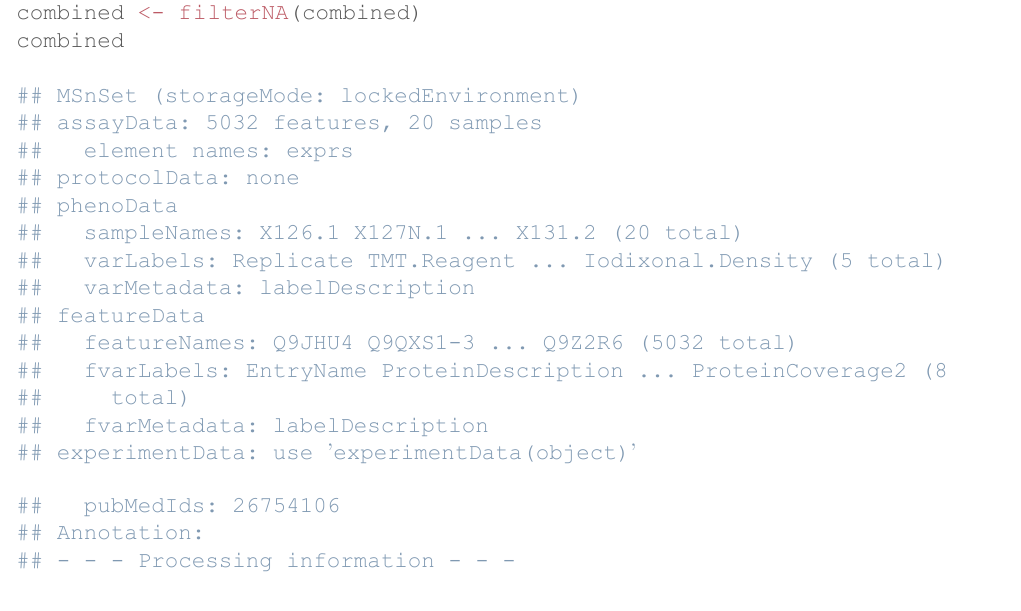
We prefer to remove proteins that were not assayed in both replicated experiments. This is done with the function that removes features (proteins) that contain more than a certain proportion (default is 0) filterNA missing values. The Processing information section summarises how combining and filtering missing values (subsetting) changed the dimensions of the